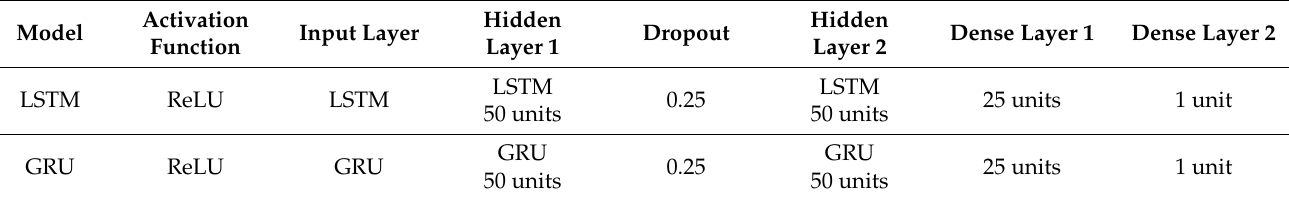
Table 6. Configuration and hyperparameters of models.